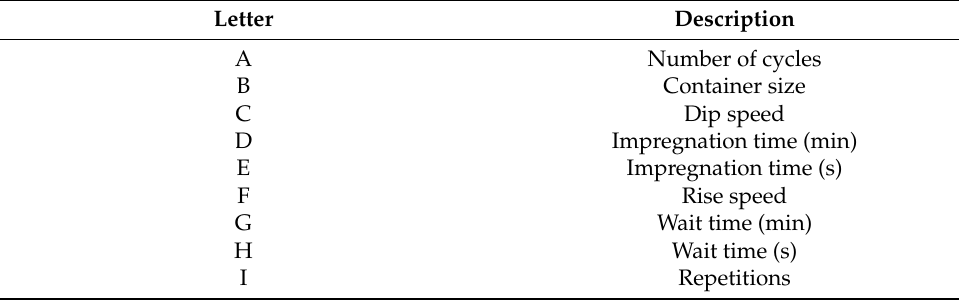
Table 3. Components of the data frame used in the mobile